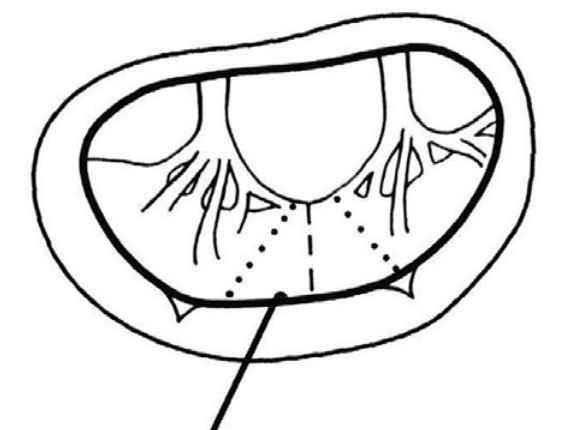
Fig. 2 - The anterior mitral leaflet is retracted by a hook. Chordae tendineae and papillary muscles of are shown. Dotted line is the chordae free portion to be excised